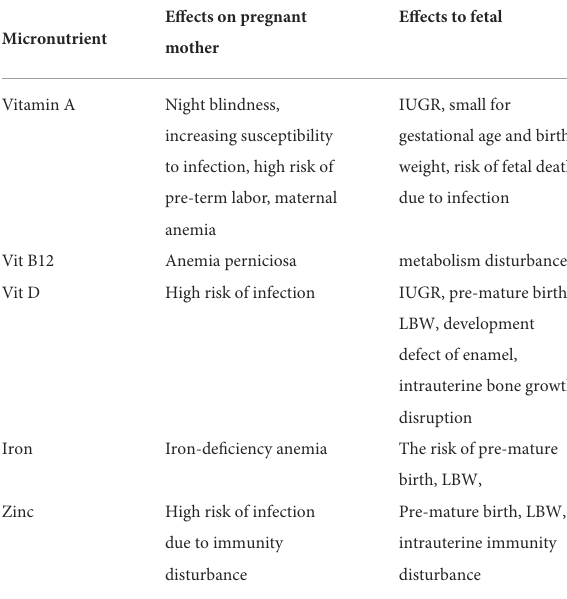
TABLE 2 Micronutrient deficiency during pregnancy and their effects